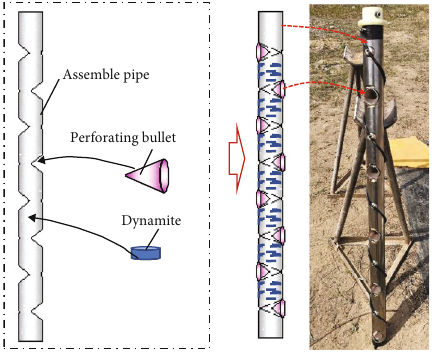
Figure 1: Assembly drawings of perforating bullets and